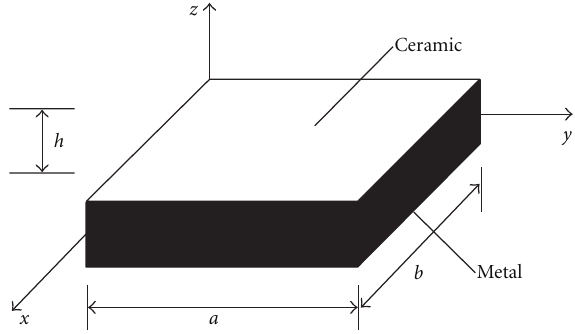
Table 1: Displacement models.